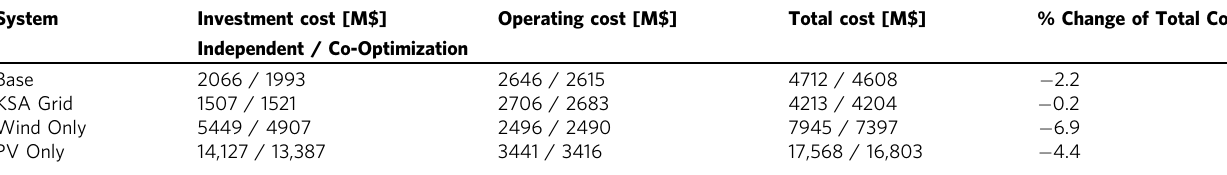
Shown are results for the Base, Kingdom of Saudi Arabia (KSA) Grid, Wind Only, and Photovoltaics (PV) Only cases.